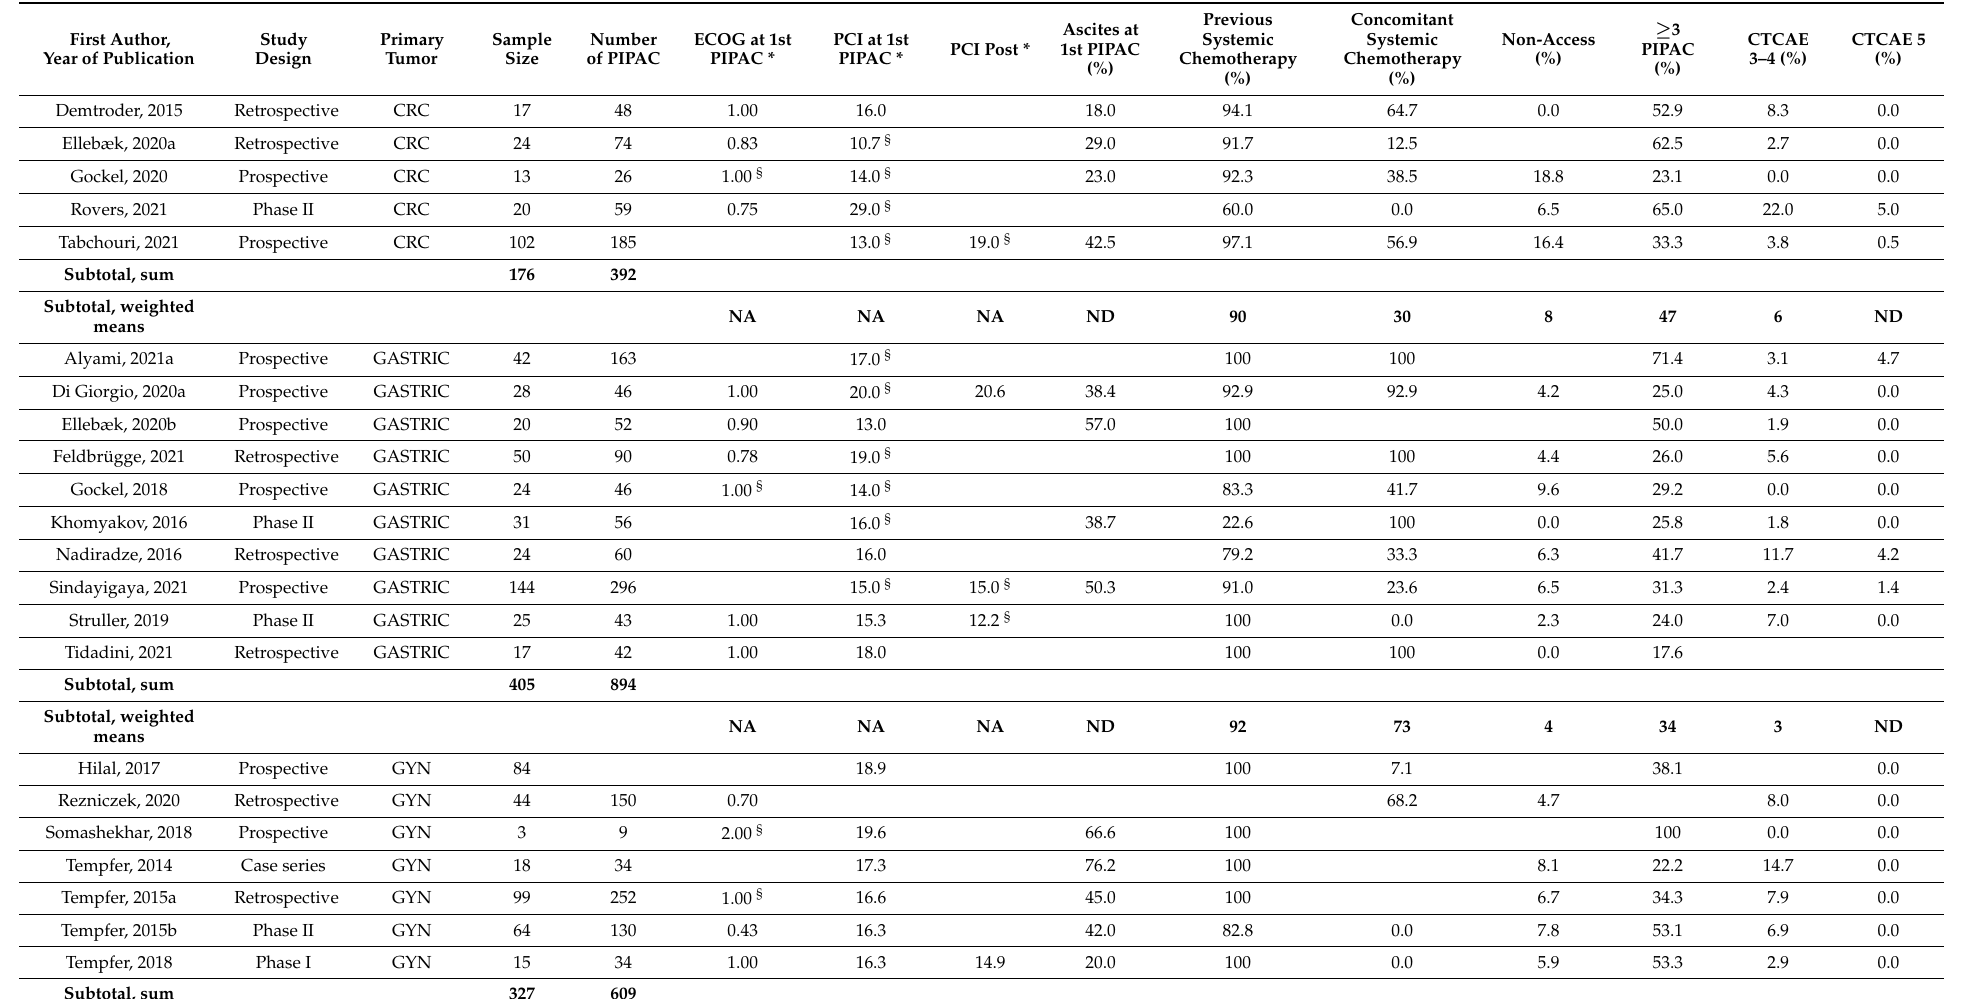
Table 3. Main characteristics of included